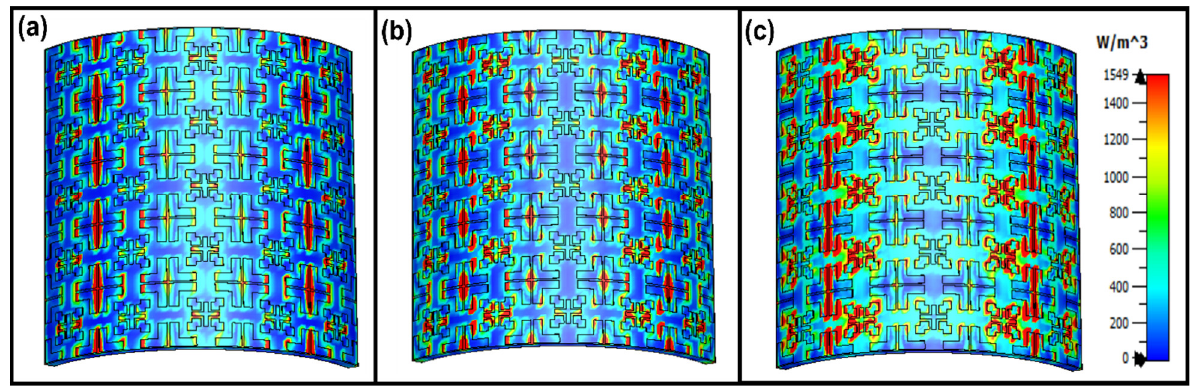
Figure 4. Distribution of the power-loss density of BBMPA structure at ( a ) 9.2, ( b ) 13.0, and ( c ) 18.2 GHz (at a bending radius of 40 mm) (for the TE polarization).